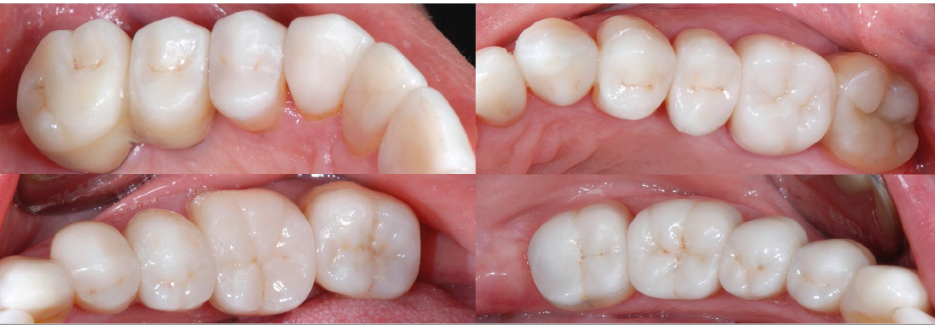
Figure 13. Details of posterior quadrant reconstruction with recovery of the vertical dimension, chewing efficiency, and aesthetics.